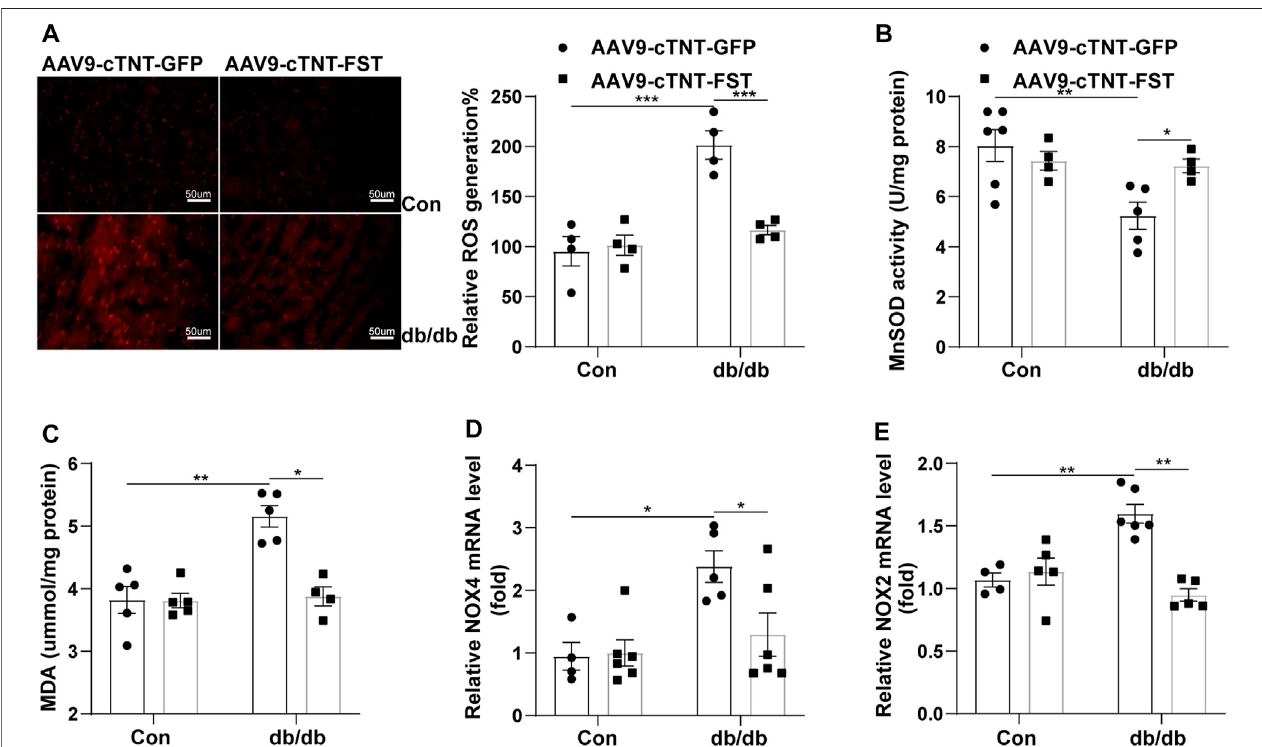
FIGURE 6 | Overexpression of FST decreases cardiac oxidative stress in db/db mice. Representative images of DHE staining and quantitative analysis of myocardial ROS levels in each group (magni fi cation: 400 × [ (A) , n (cid:1) 4]). The activity of MnSOD, the content of MDA, and the quantitative real-time PCR analysis of mRNA transcription of NOX4 and NOX2 in heart tissues (B – E, n ≥ 4).* p < 0.05; ** p < 0.01; *** p <